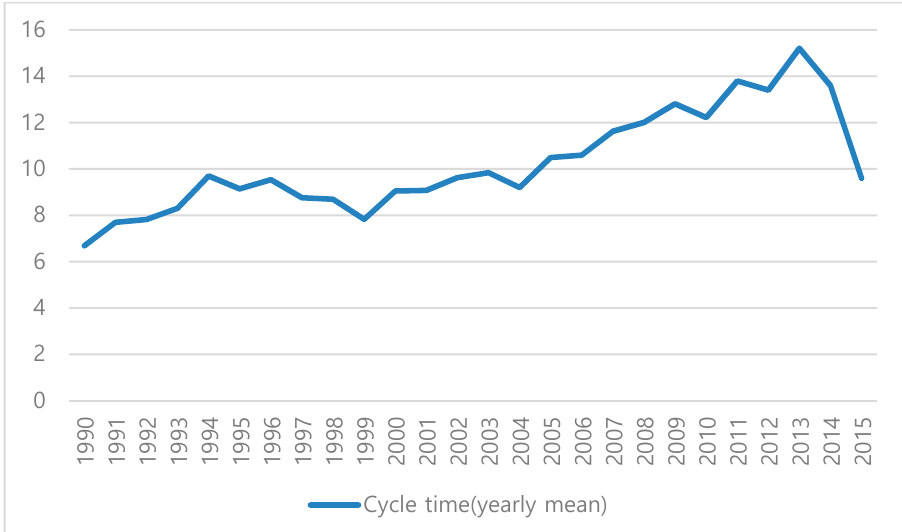
Figure 8. Average cycle time of Korean firms. Table 7. Trends of the innovation variables over the three sub-periods.